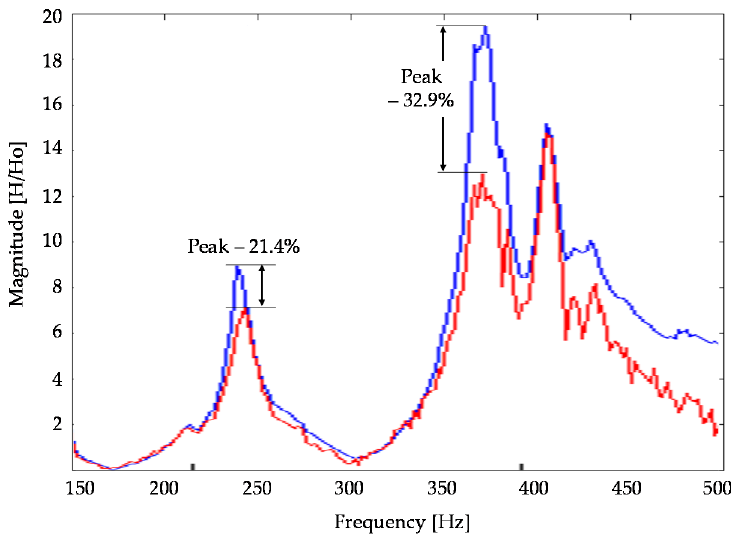
Figure 10. Frequency response function (FRF) of X axis with control (red line) and without control (blue line).